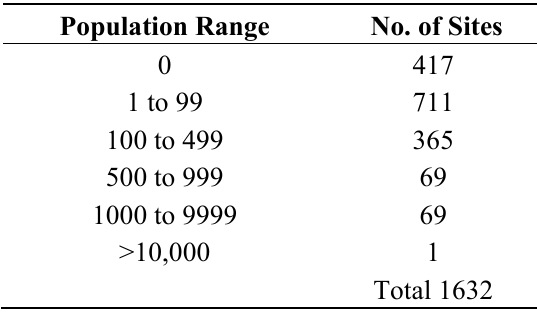
Table 4. Dasymetric population estimates within 3 km of unconventional gas extraction sites. Population